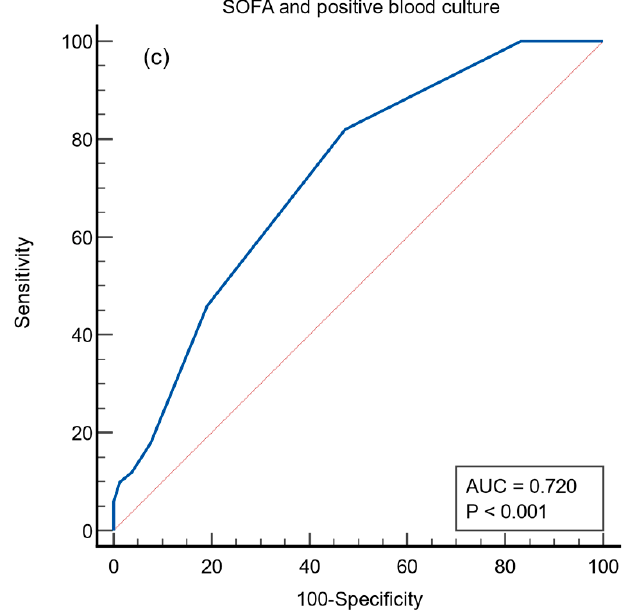
Figure 5. Receiver operating characteristic curve for the SOFA score as a predictor of severe acute cholangitis ( a ), shock ( b ), and positive blood culture ( c ). SOFA, Sequential Organ Failure Assessment.